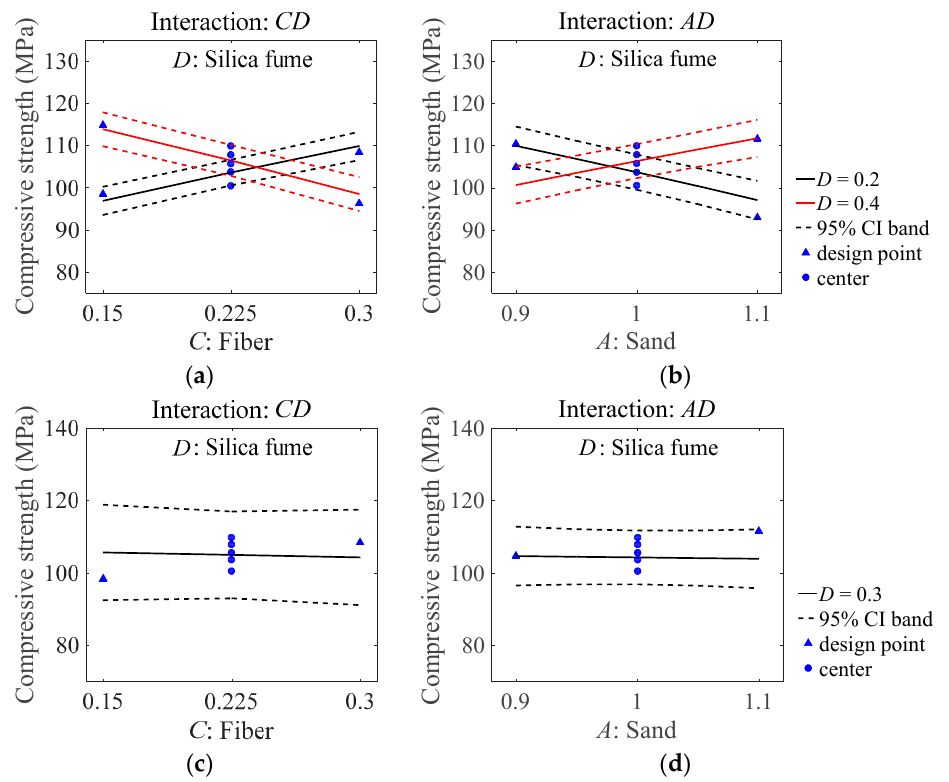
Figure 7. Influence of CD and AD on compressive strength. ( a ) Interaction of C and D , D = 0.2, D = 0.4; ( b ) interaction of A and D , D = 0.2, D = 0.4; ( c ) interaction of C and D , D = 0.3 and ( d ) interaction of A and D , D = 0.3.